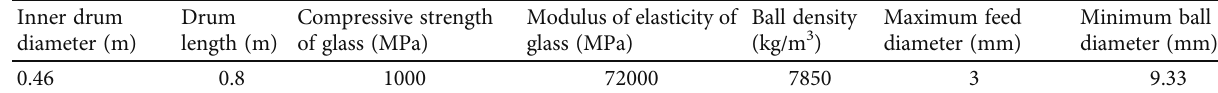
Table 8: Calculation of minimum ball diameter.